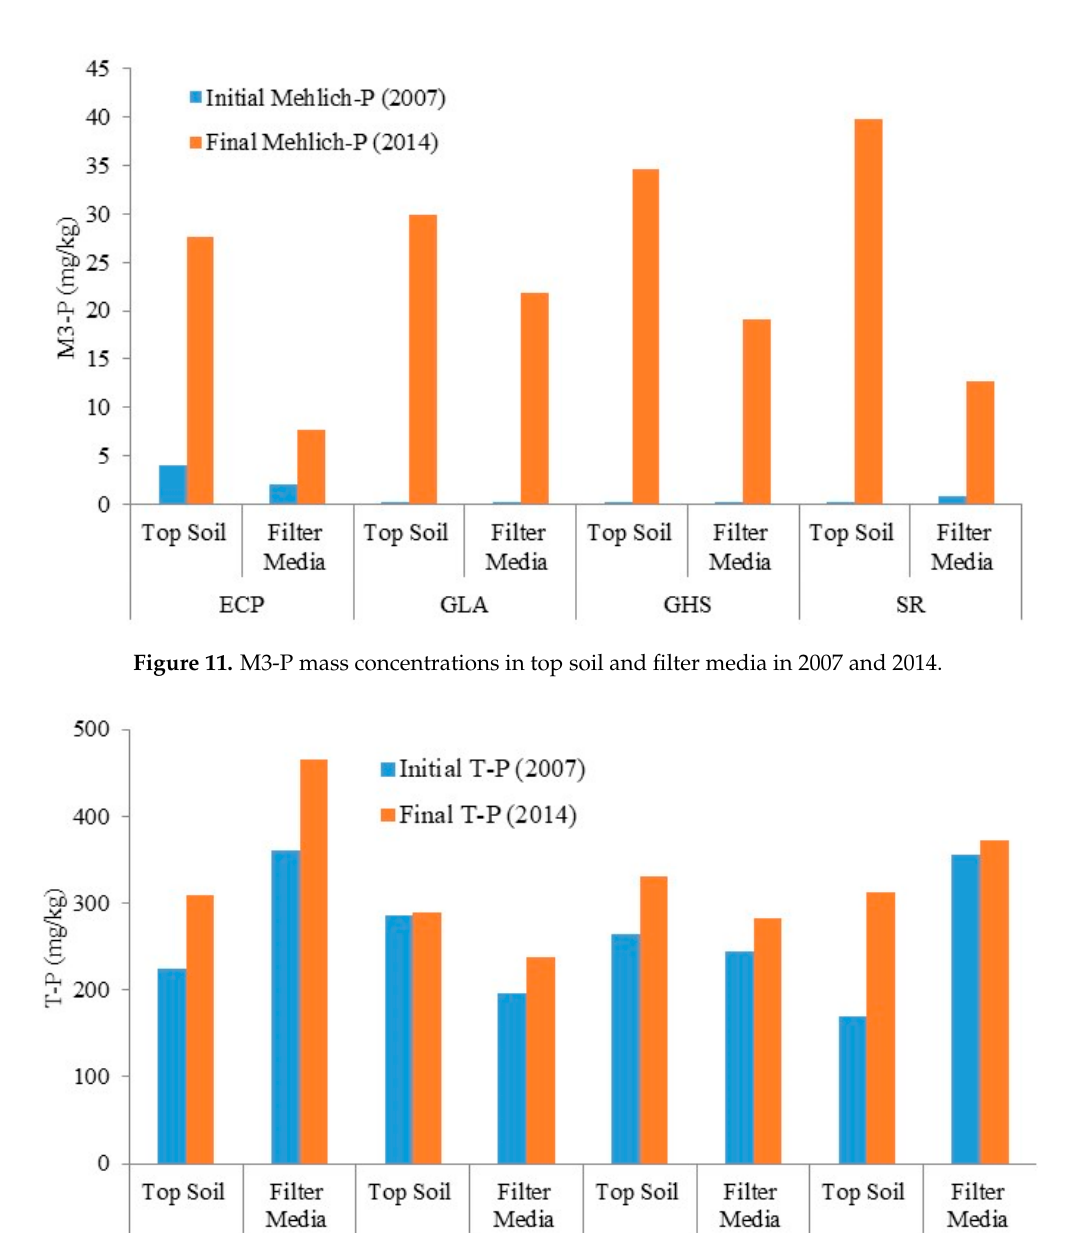
Figure 10. WS-P mass concentrations in top soil and filter media in 2007 and 2014.